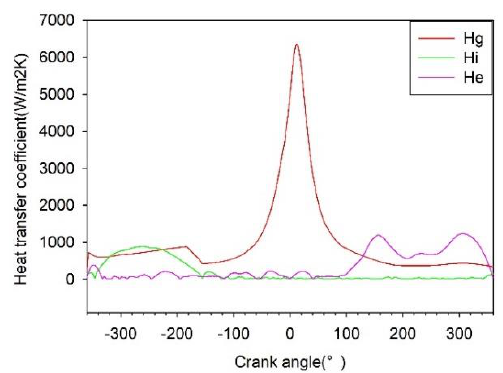
Figure 5. Curves of the transient heat transfer coefficient.